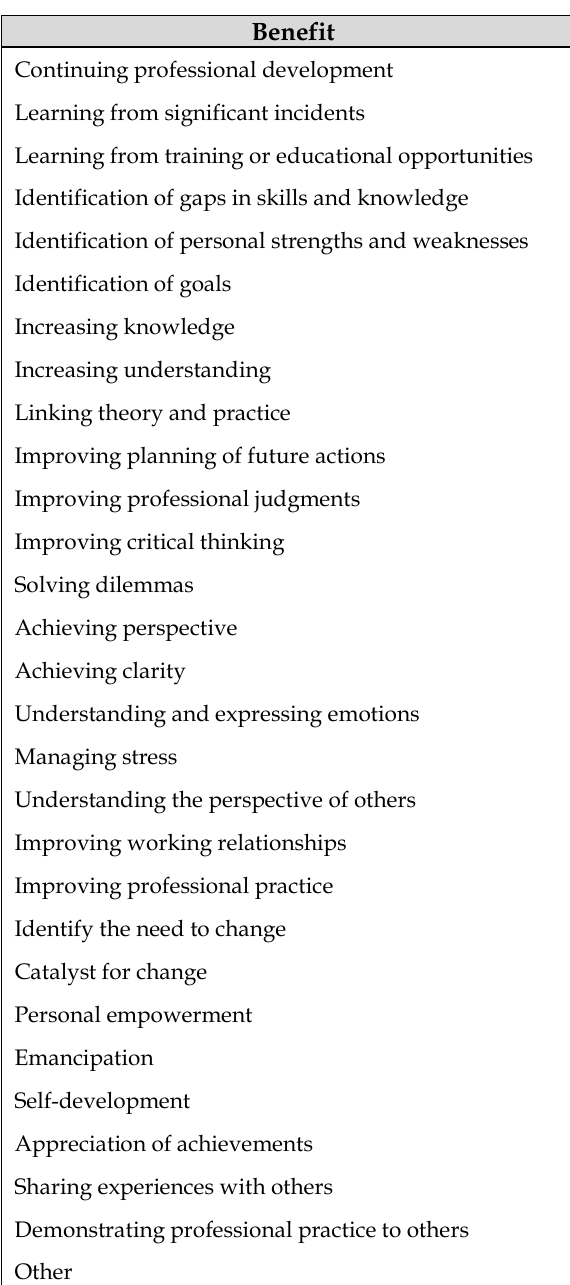
Table 1 Perceived benefits of reflective practice